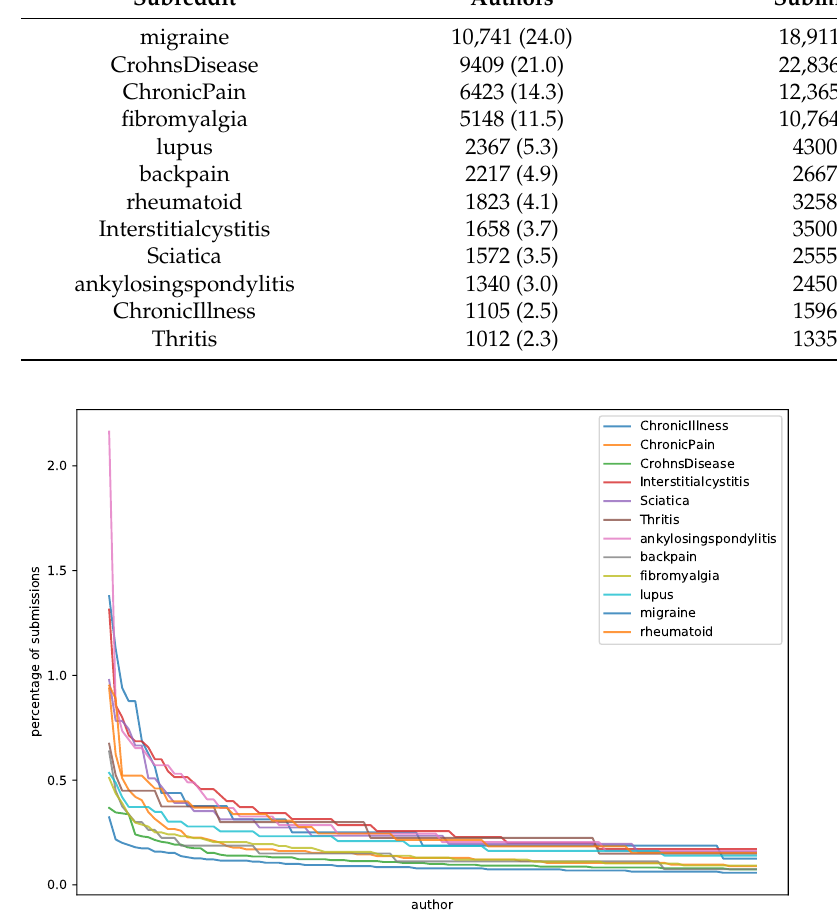
Figure A8. Percentage of submissions per author for each subreddit.